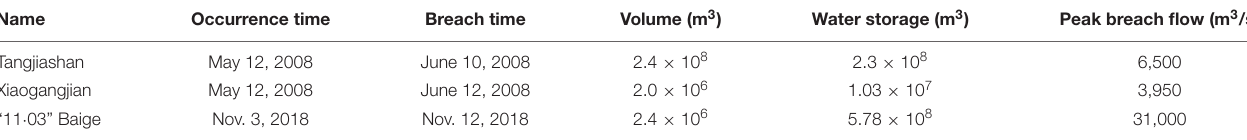
TABLE 3 | Primary features of dammed lakes.